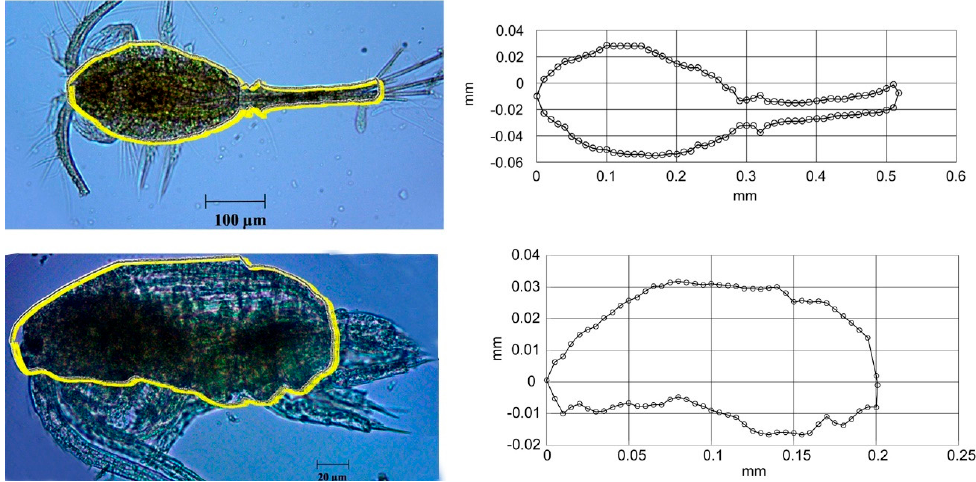
Figure 12. Shape and length of Oithona sp. (dorsal aspect) and Paracalanus sp. (side aspect).